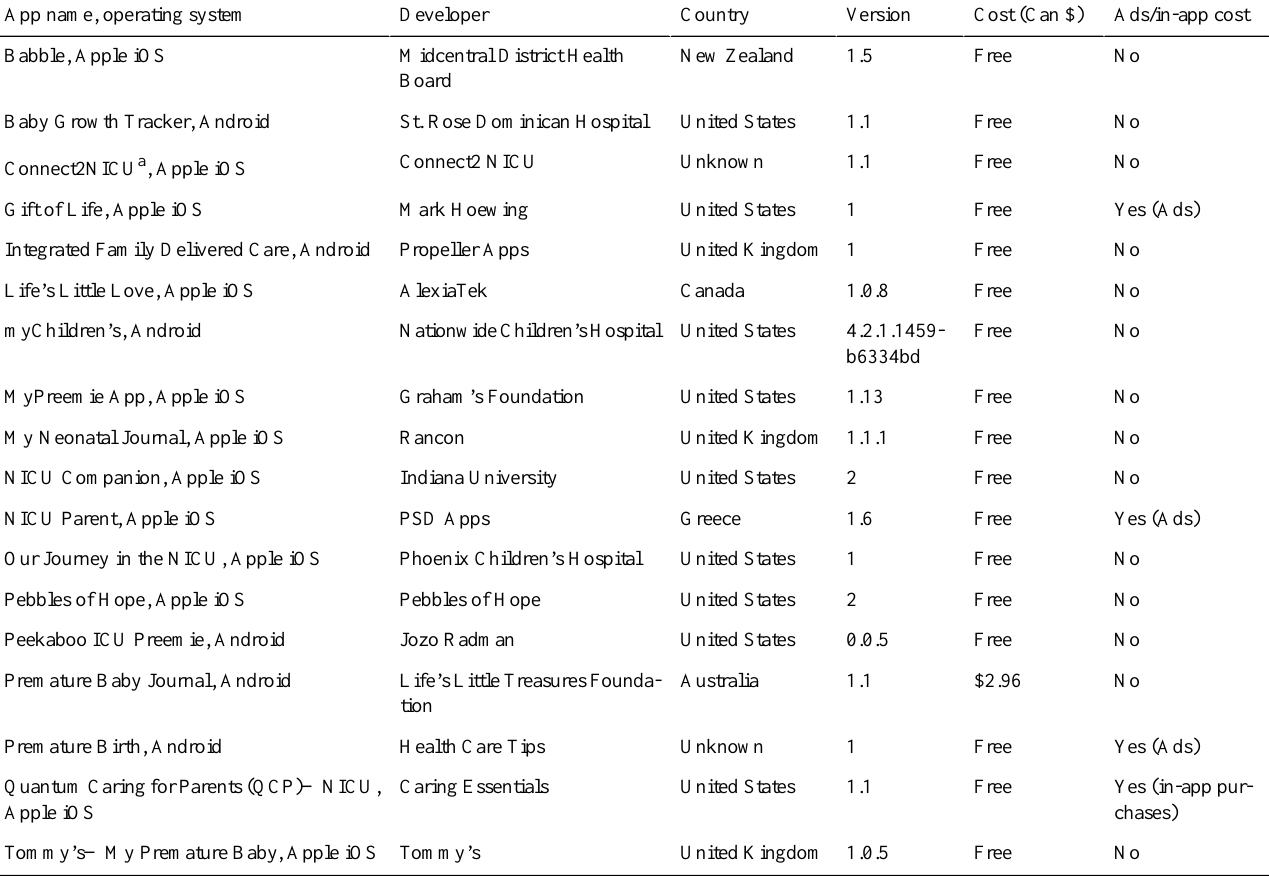
Table 1. Description of apps.